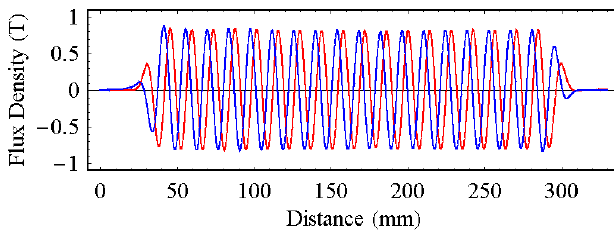
FIG. 15. (Color) Measured on-axis magnetic field in both trans- verse directions for the SC undulator.